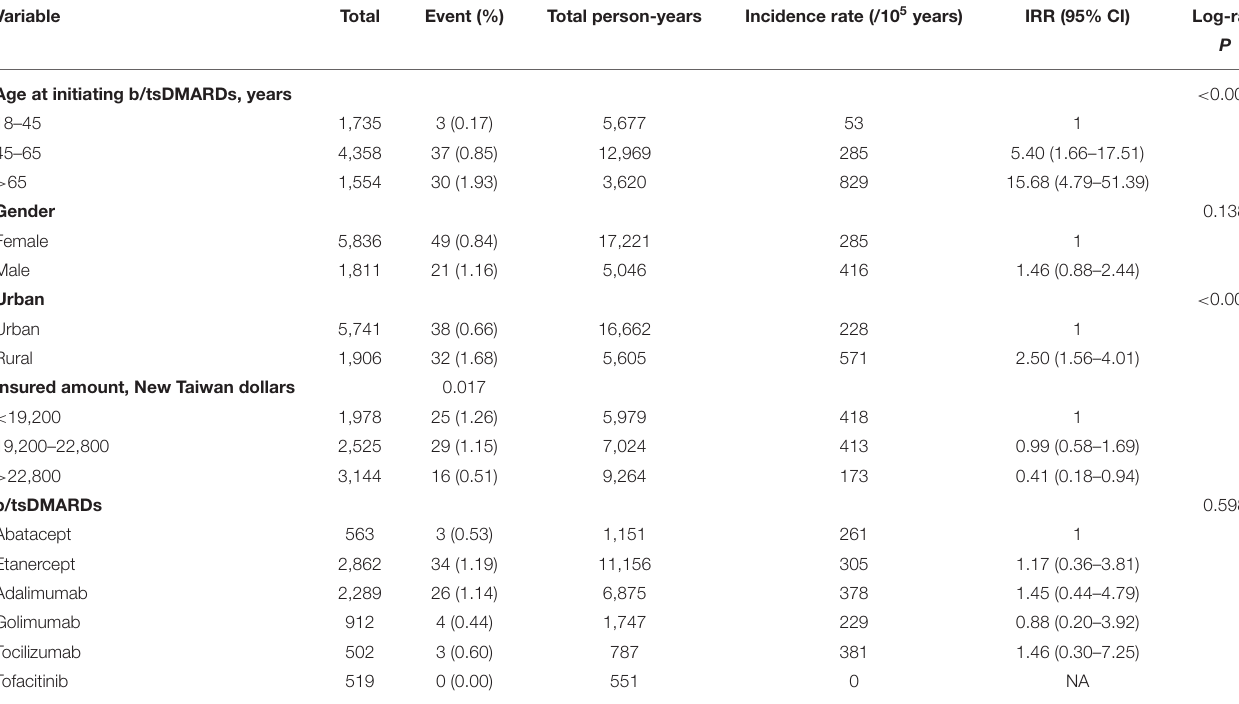
TABLE 2 | Incidence rate of infection requiring hospitalisation in patients receiving b/tsDMARDs.